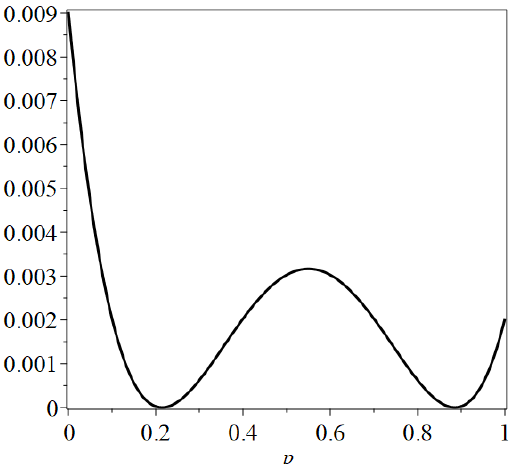
Figure 4. Numerical simulation of profit difference between the hybrid platform mode and merchant mode.